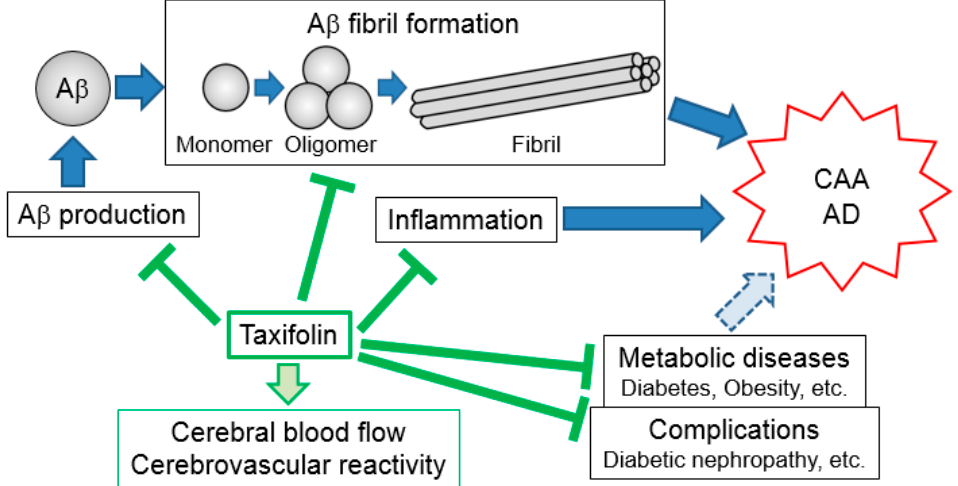
Figure 1. Pleiotropic beneficial effects of taxifolin. Taxifolin suppresses A β production, fibril